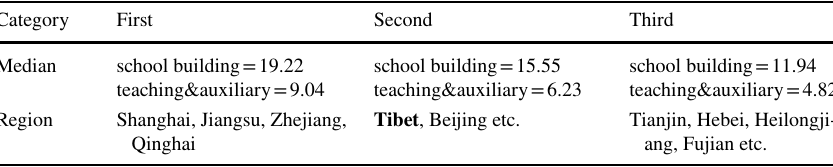
Table 9 Clustering of construction area of school building and teaching & auxiliary facilities (junior high school) Category